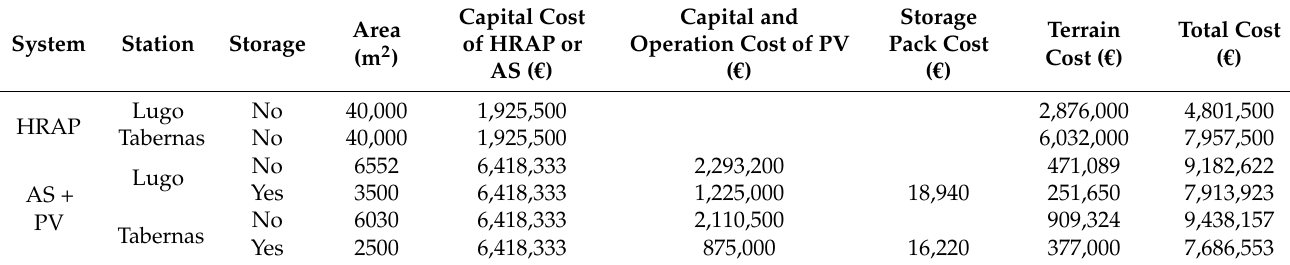
Table 5. Economic costs for the systems and stations considered (with storage and without